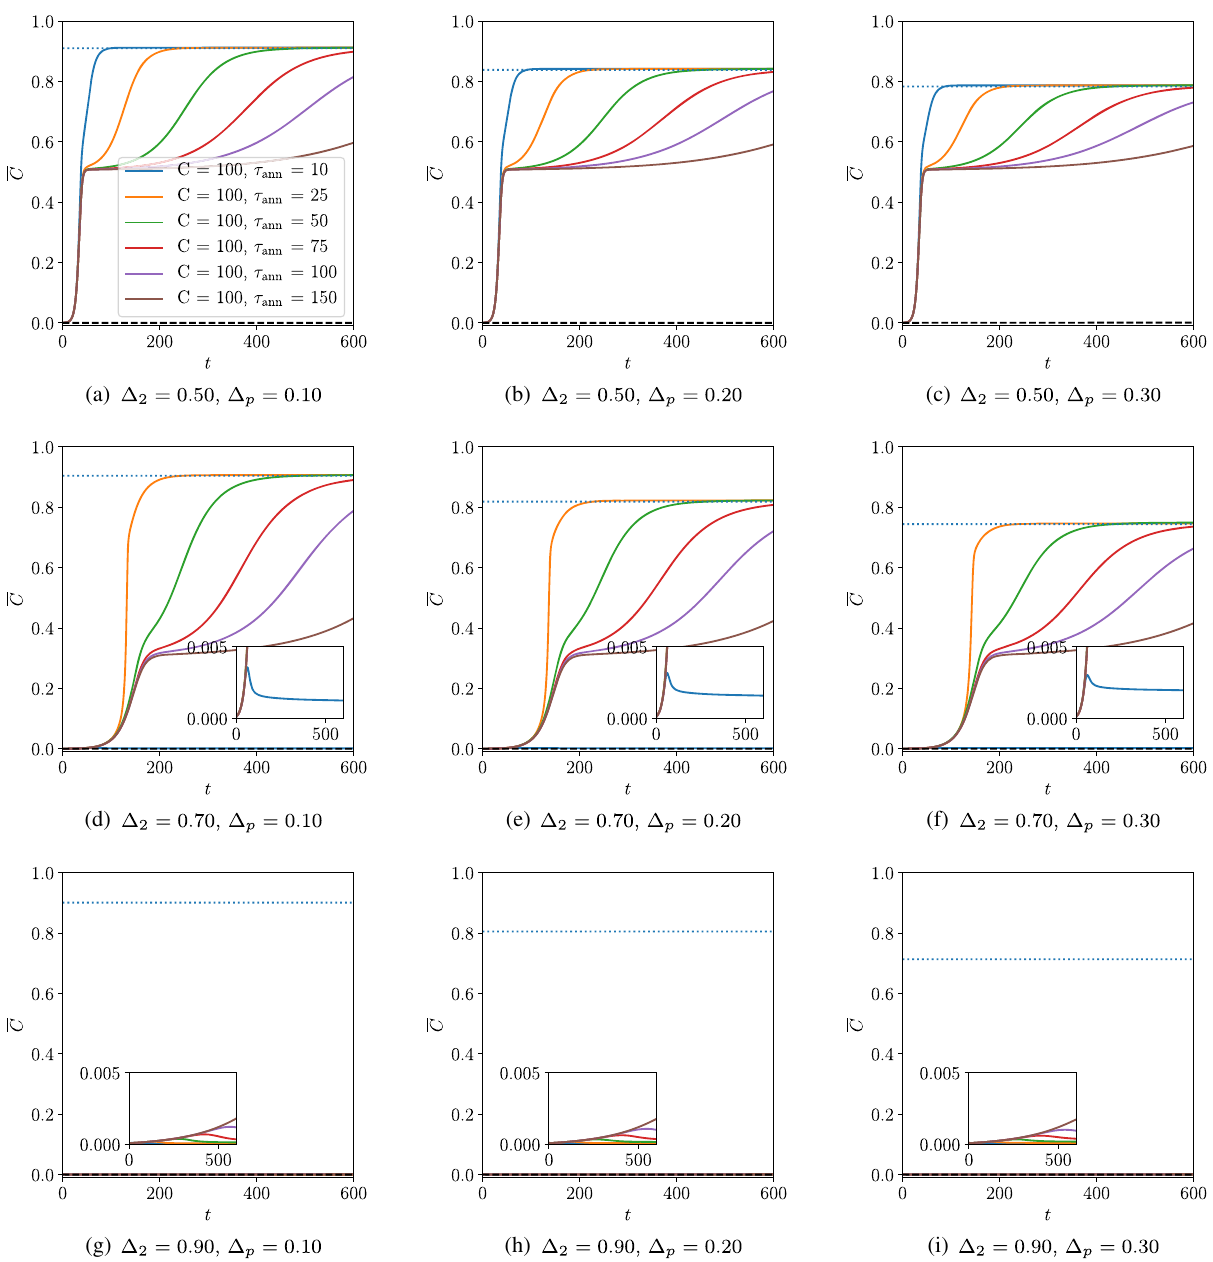
FIG. 18. The figures show the correlation with the signal in time obtained using different annealing protocols, whose details are reported in the legend of the first figure. All of the protocols have C ¼ 100 , which means that all the dynamics start with close effective Δ ∼ 100 , T 0 Þ Δ ≃ 100 and an initial overlap ¯ C 10 − 4 . What changes among the different lines is the relaxation speed, from the 0 ¼ p p ð p fastest (drawn in blue) to the slowest (drawn in brown). They are compared with the asymptotic value of AMP (dotted line) and the Langevin dynamics without tensor annealing (dashed